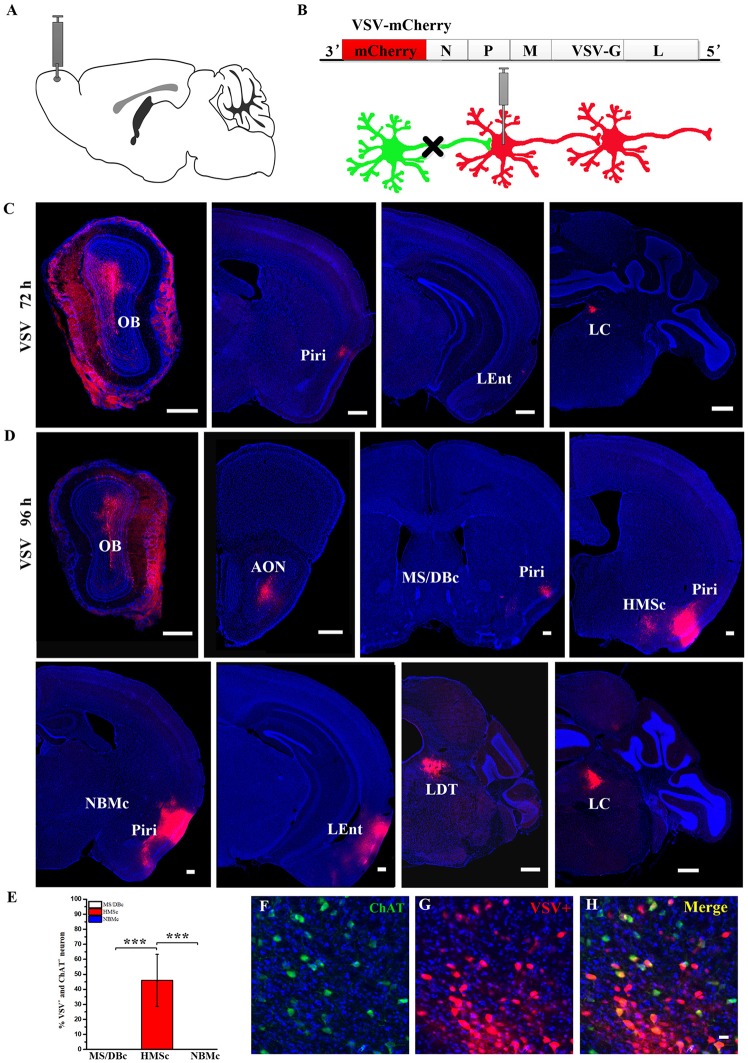
The outputs of the olfactory bulb (OB) to the BF. (A) Diagram of vesicular stomatitis virus (VSV) injection site. (B) Schematic of VSV anterograde transsynaptic labeling. (C) VSV infected olfactory relative brain regions by 72 h. (D) VSV infected olfactory relative brain regions by 96 h. Neurons (red) were infected by VSV. Scale Bar, 500 μm. (E) Quantitative analysis of the cholinergic neurons infected by VSV in different subsets of the BF. (F–H) Confirmation of cholinergic neurons infected by VSV in HMSc. ChAT+ neurons by anti-Choline Acetyltransferase (green), VSV+ neurons (Red), Merge (Yellow): ChAT+ neurons infected by VSV. Scale bar, 20 μm. n = 4. *P < 0.05, **P < 0.01 and ***P < 0.001.